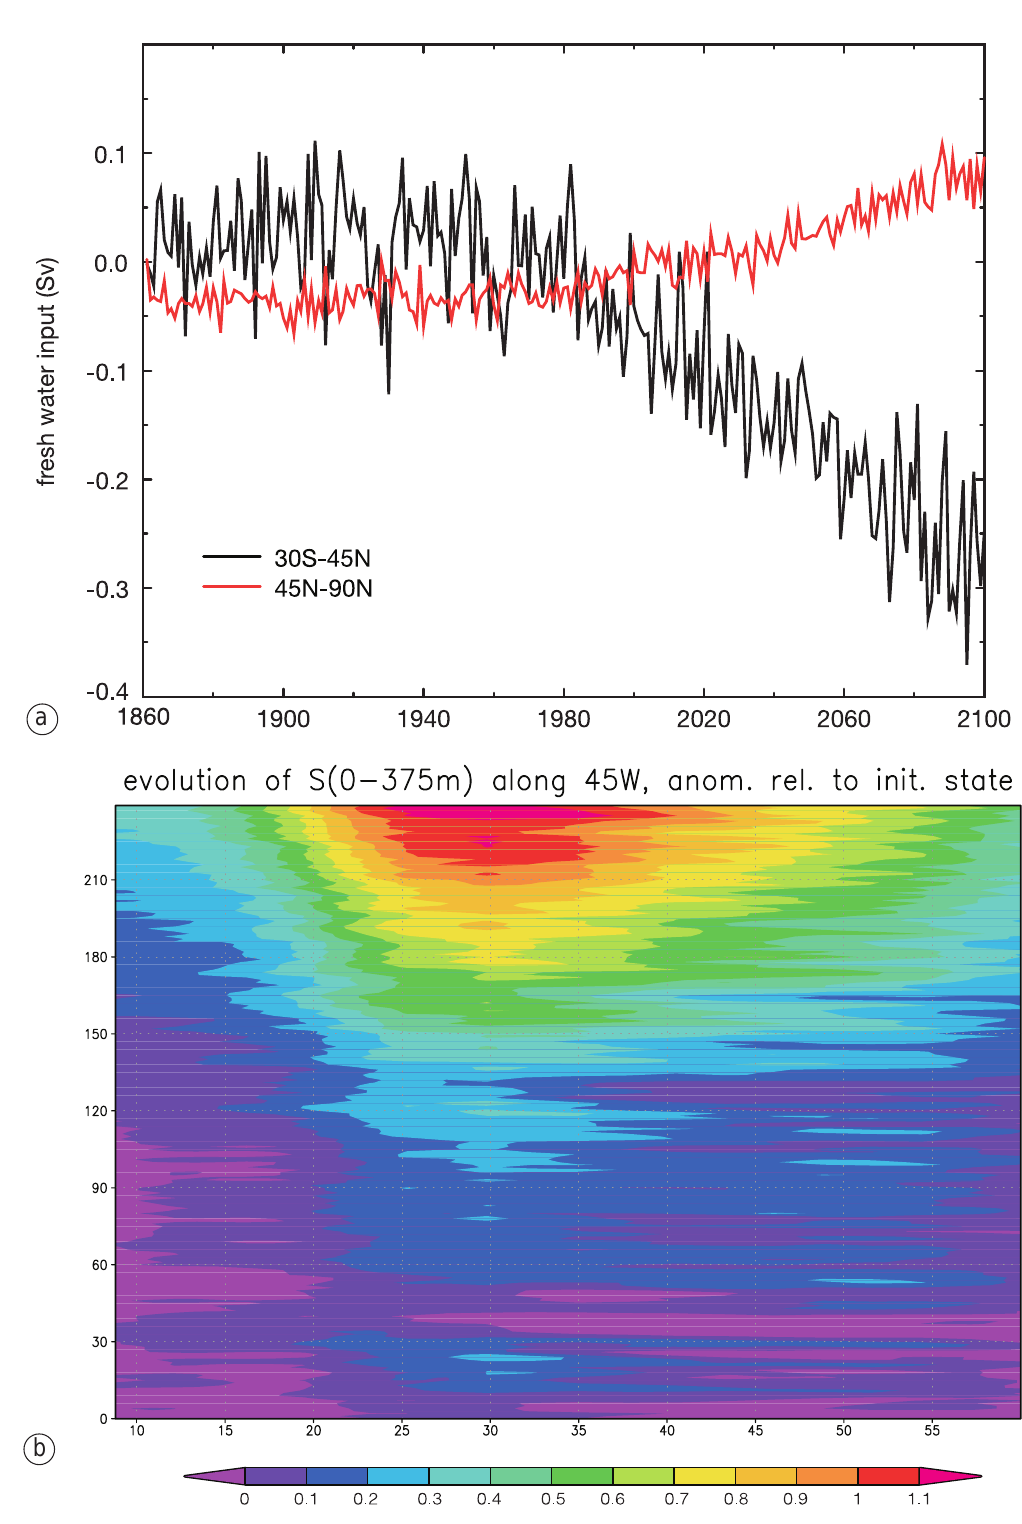
Fig. 4a,b. a) Time series of anomalous freshwater input (Sv) into the Atlantic in the region 30 ° S-45 ° N (black curve) and into the mid and high latitudes (45 ° N-90 ° N, red curve). b) Temporal evolution of the salinity anomalies (psu) averaged over the upper 375 m along 45 ° W. The northward propagation of the salinity anomalies from the subtropics to higher latitudes can be clearly seen by the tilt of the contours. The anomalies are calculated by subtracting the initial